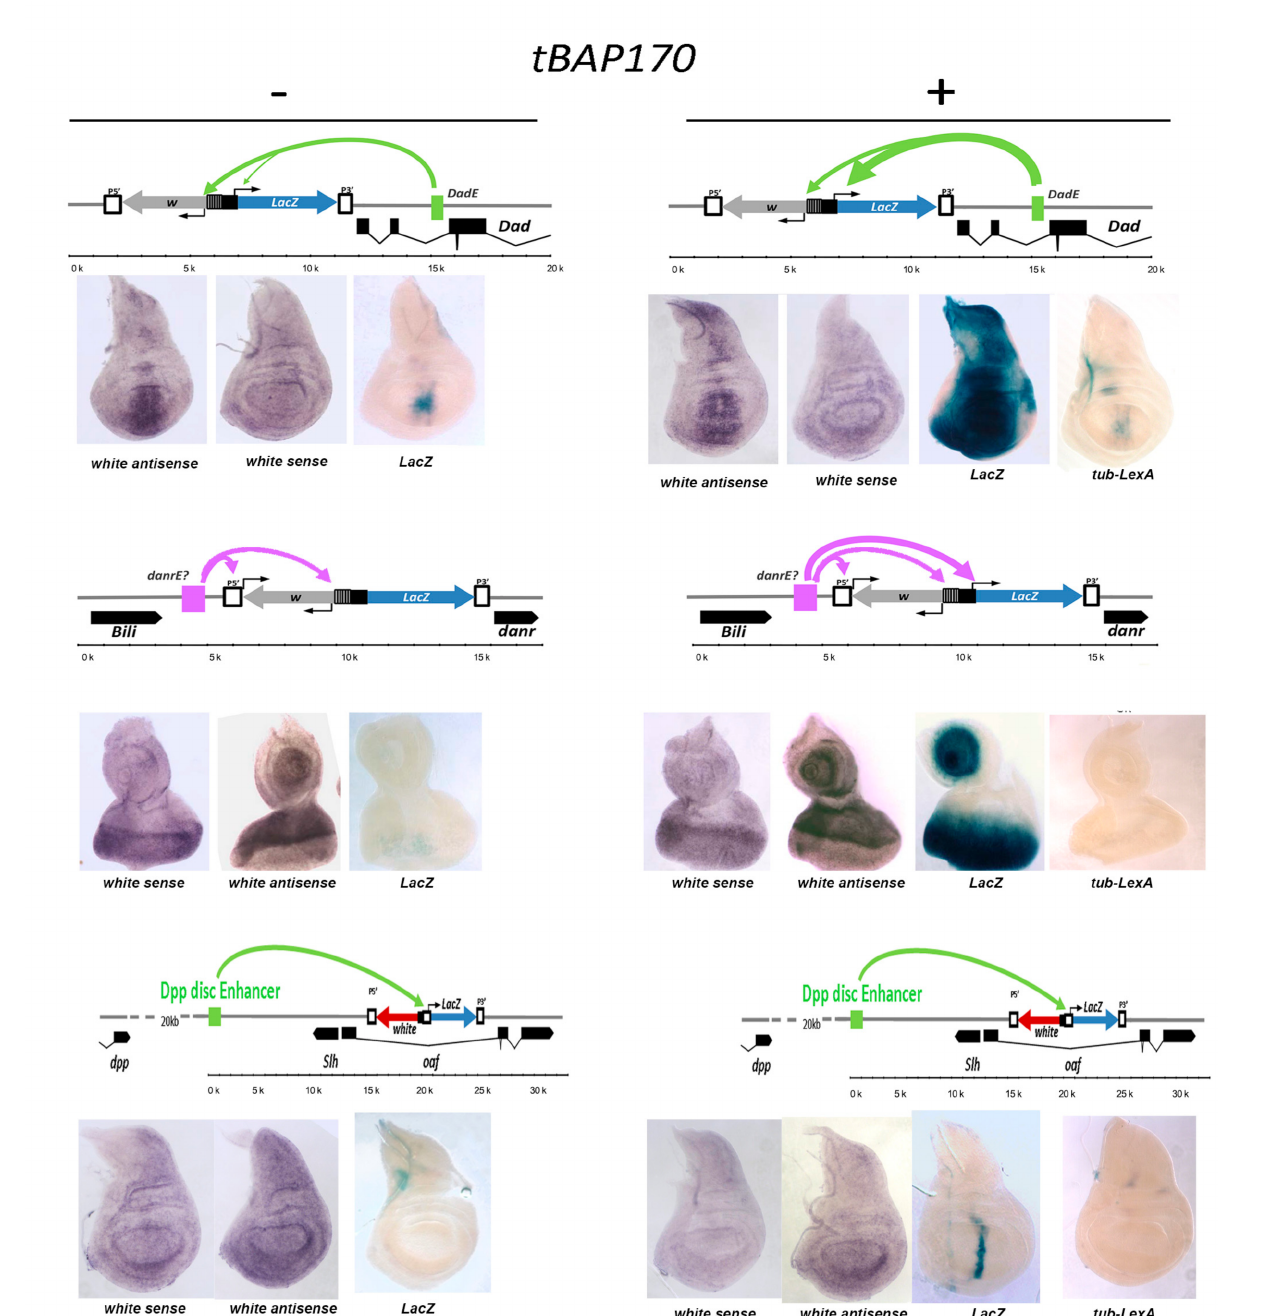
Figure 3. Enhancer capture by tBAP170 at the hsp70 promoter at the LexAop-LacZ Dad , LexAop-LacZ danr , and LexAop-LacZ Dpp transgenes. Schematic drawing of the positions of the LexAop-LacZ responders, the enhancers, and flanking genes in the Dad , danr, and dpp genomic regions (top of each panel). Arrows in the genetic maps indicate the interaction between promoters and flanking enhancers; their thickness is proportional to the level of activation. Beta-gal activity is undetectable in transgenic larvae carrying the specific LexAop-LacZ responder alone (left of each panel), while detected in combination with P tub - LexA:BAP170 (on the right). The negative control (P tub - LexA ) is also given. Activity of the hsp70 promoter was monitored by X-gal staining. The Dad and danr enhancers can spontaneously activate the mini - white and P-transposase promoters (detected by in situ hybridization with an antisense or a sense probe to the white gene, respectively) independently on